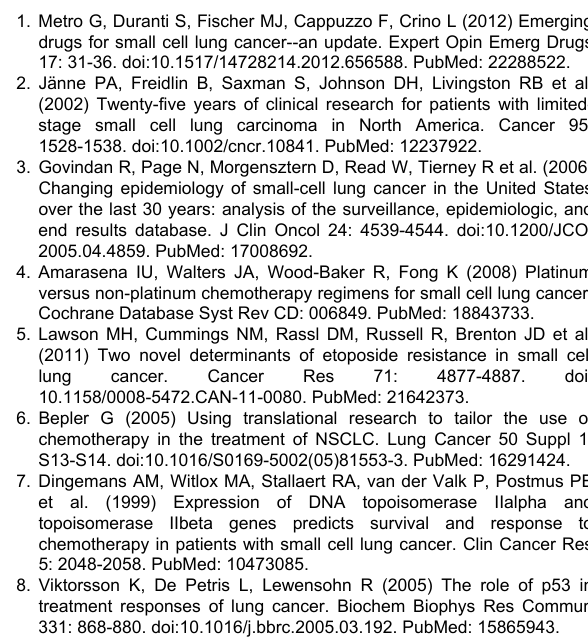
Table S5. ES-SCLC#: Correlation of genes’ expression value and Progression Free Survival and Overall